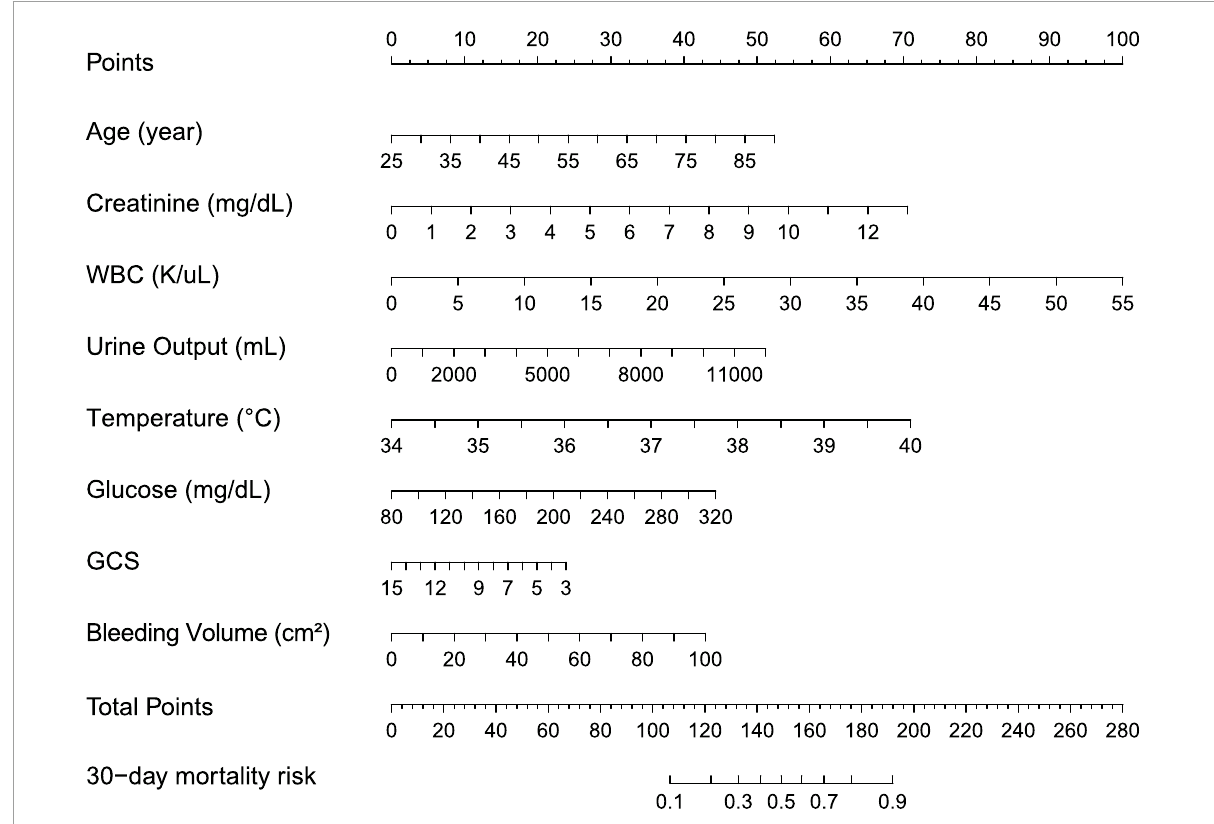
FIGURE3 Thirty-day mortality nomogram for intracerebral hemorrhage. Nomogram included age, GCS, creatinine, WBC, temperature, glucose, urine output, and bleeding volume for predicting 30-day mortality after an acute intracerebral hemorrhage. The total point was calculated as the sum of the individual score of each of the seven variables included in the nomogram. The patient was evaluated according to each variable, and the total points were given according to the nomogram. The patient was evaluated according to the specific data of each variable, and a total score was given according to the nomogram. Based on this value, the risk of 30-day morality could be